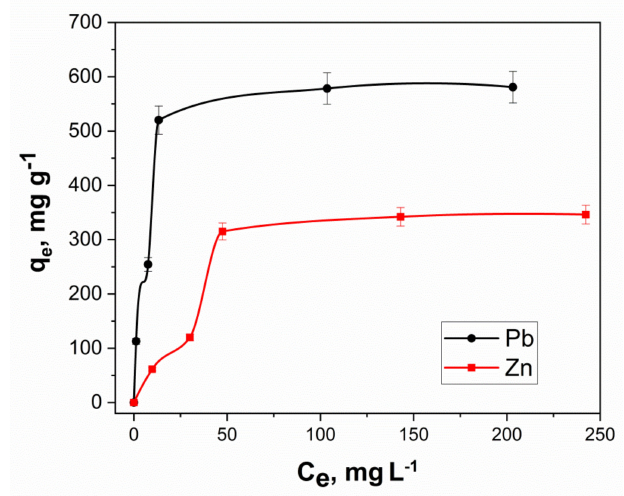
Figure 11. The isotherms of Pb 2+ and Zn 2+ sorption onto